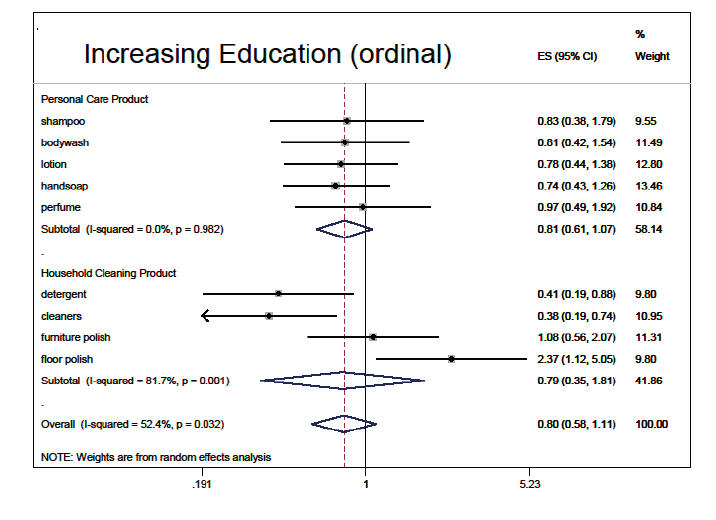
Figure 5. Demographic predictors of fragranced product use (meta-analysis of multivariable model results): increasing education (ordinal). Models are ordered logistic regressions with random intercepts for twin pair and address, with fixed effects for age, sex, education, ever being bothered by fragrance and race, restricted to white participants only ( N = 280). Missing